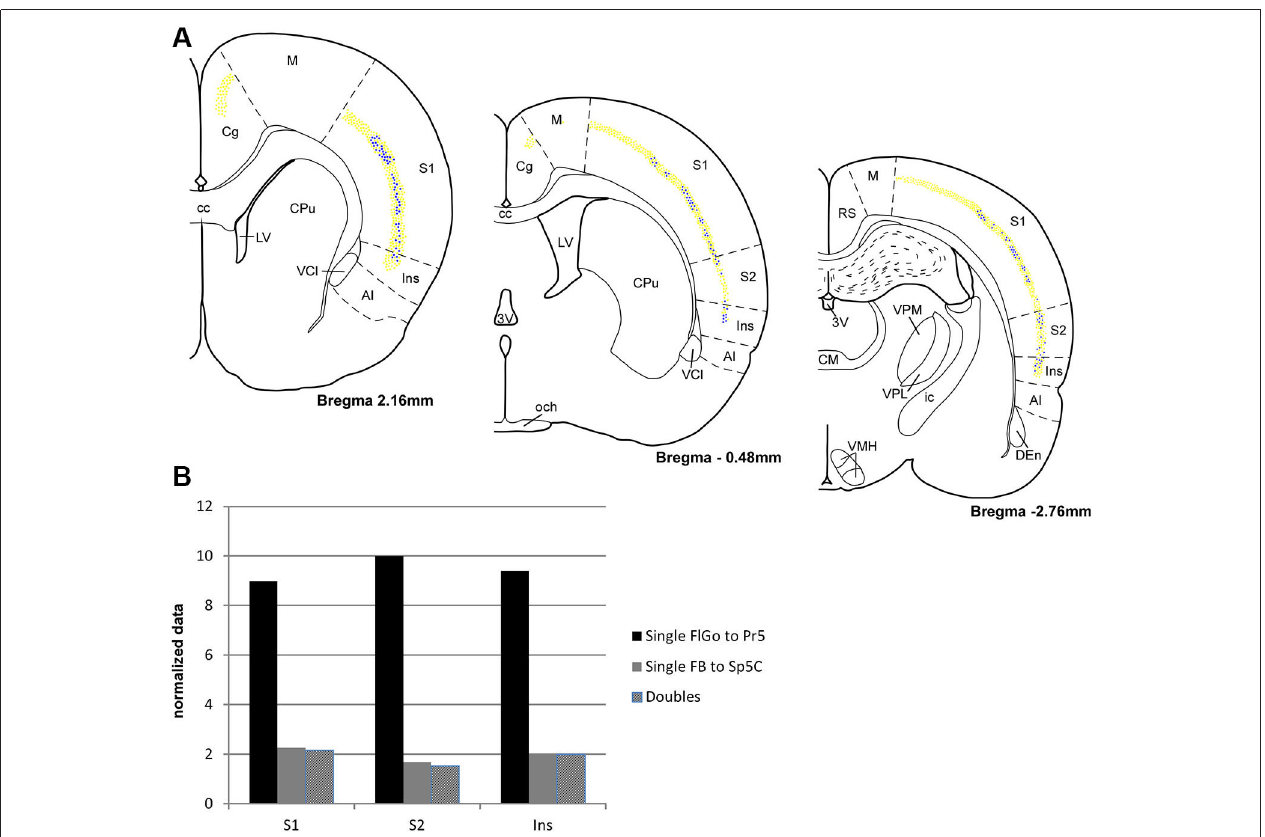
FIGURE 3 | (A) Schematic drawings of coronal hemi-sections from rostral to caudal levels through rat brain showing the distribution FLGo (light dots) and FB (dark dots) labeled neurons in different cortical areas. (B) Graphic representation of percentages of single FlGo, single FB and double-labeled neurons in different cortical areas. Abbreviations: 3V: 3rd ventricle, AI: agranular insular area, CC: central canal, Den: dorsal endopiriform